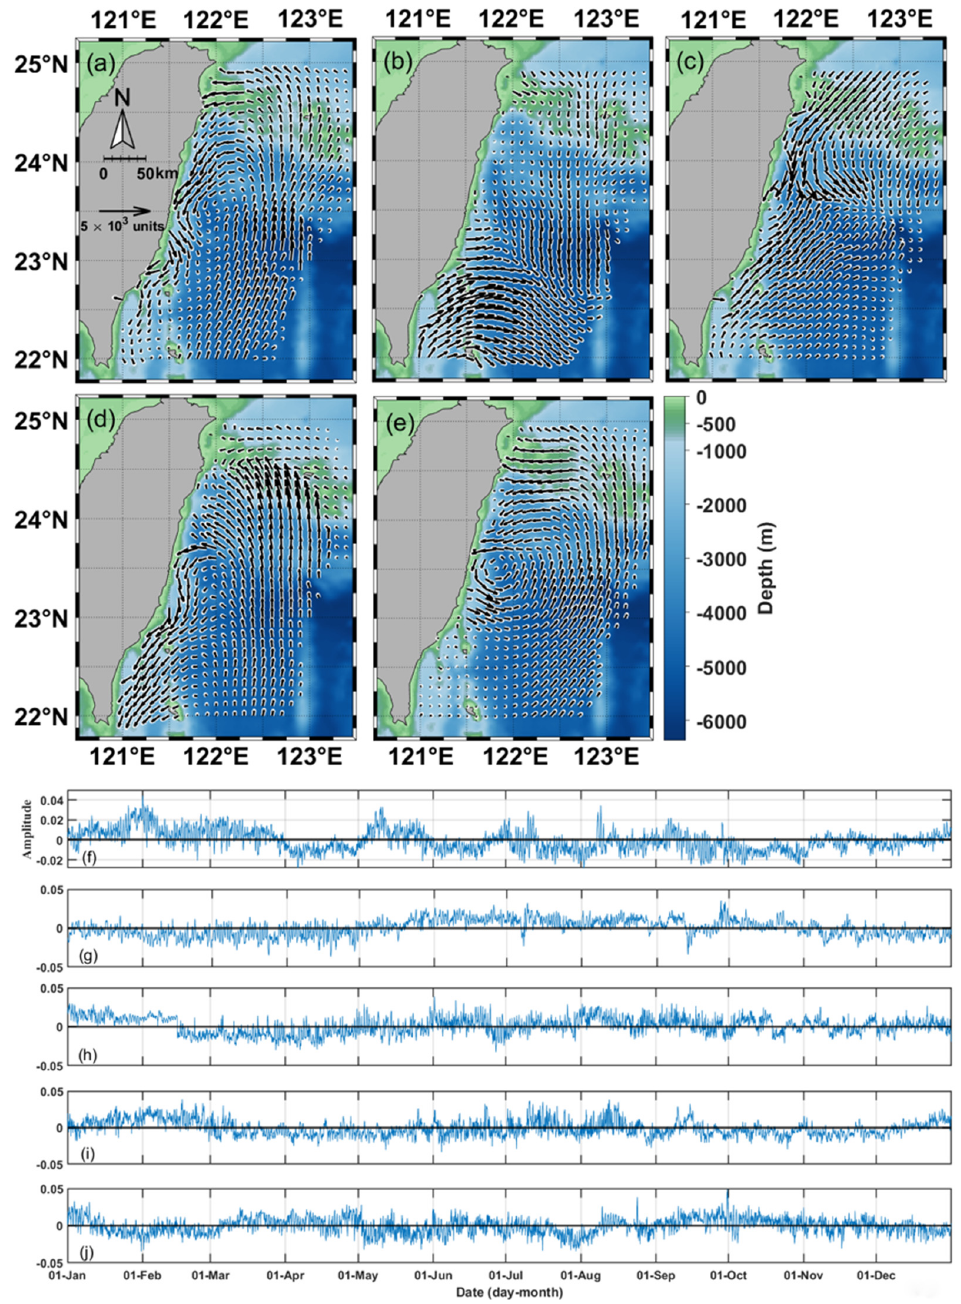
Figure 8. Same as Figure 6, but for EOF3.